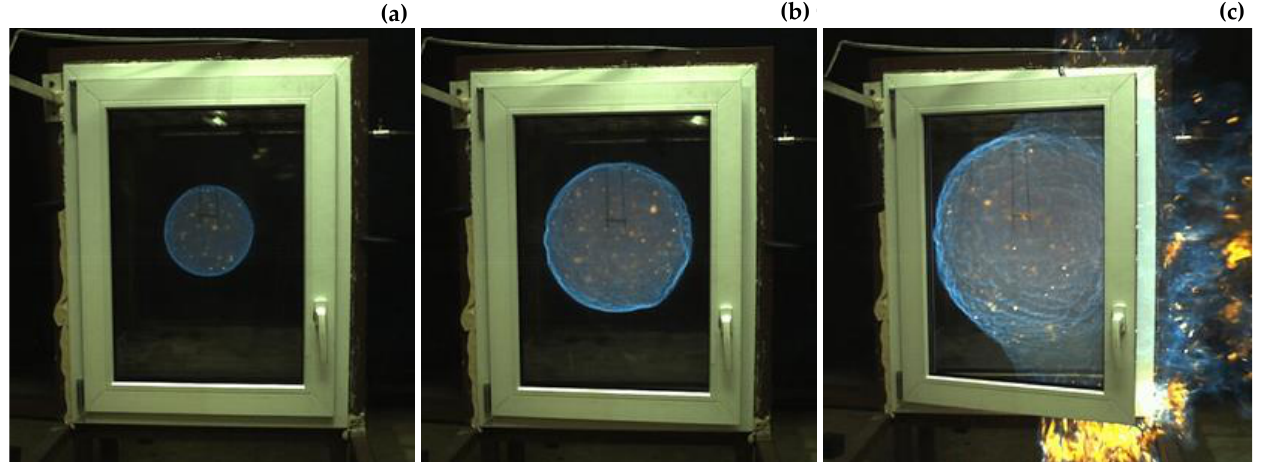
Figure 3. Instant photos of combustion explosion of a propane-air mixture in a room with a hinged window, which plays the role of an EVS: ( a ) the EVS begins to open; ( b ) a photo taken 30 ms after initiation of opening, corresponding to the EVS opening process; ( c ) a photo taken 60 ms after initiation of opening, corresponding to the moment when explosion products break out into the atmosphere.